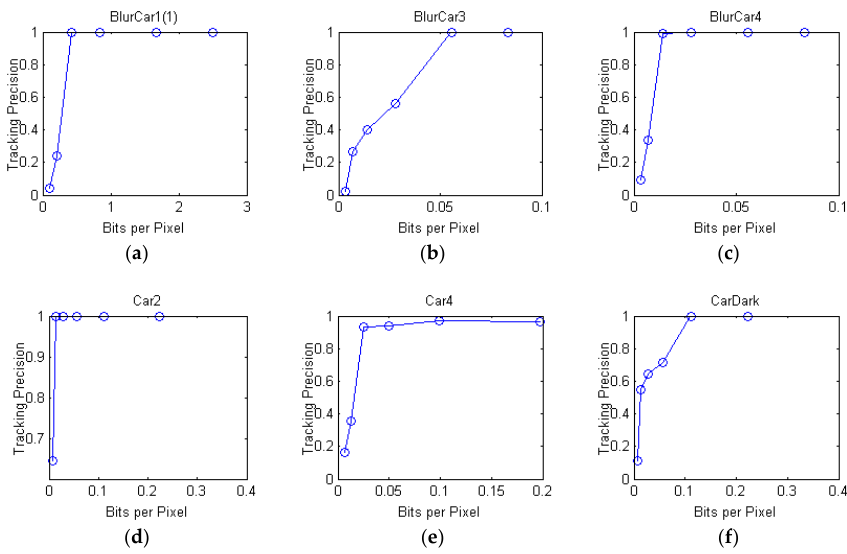
Figure 8. Tracking precision of each video sequences: ( a ) BlurCar1(1); ( b ) BlurCar3; ( c ) BlurCar4; ( d ) Car2; ( e ) Car4; ( f ) CarDark.